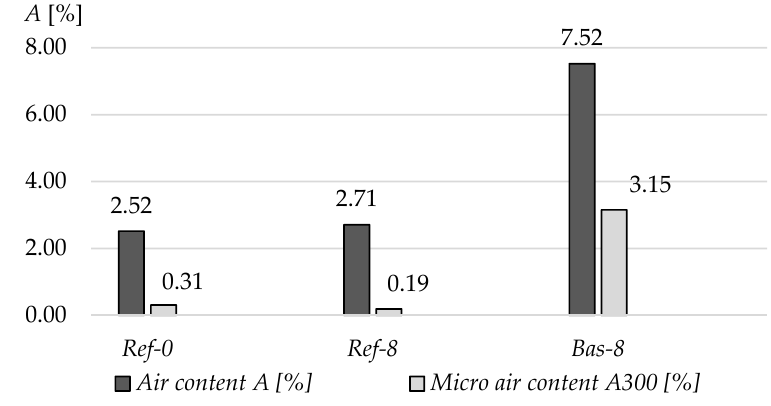
Figure 7. Air content of the tested concretes examined by means of optic porosimetry.